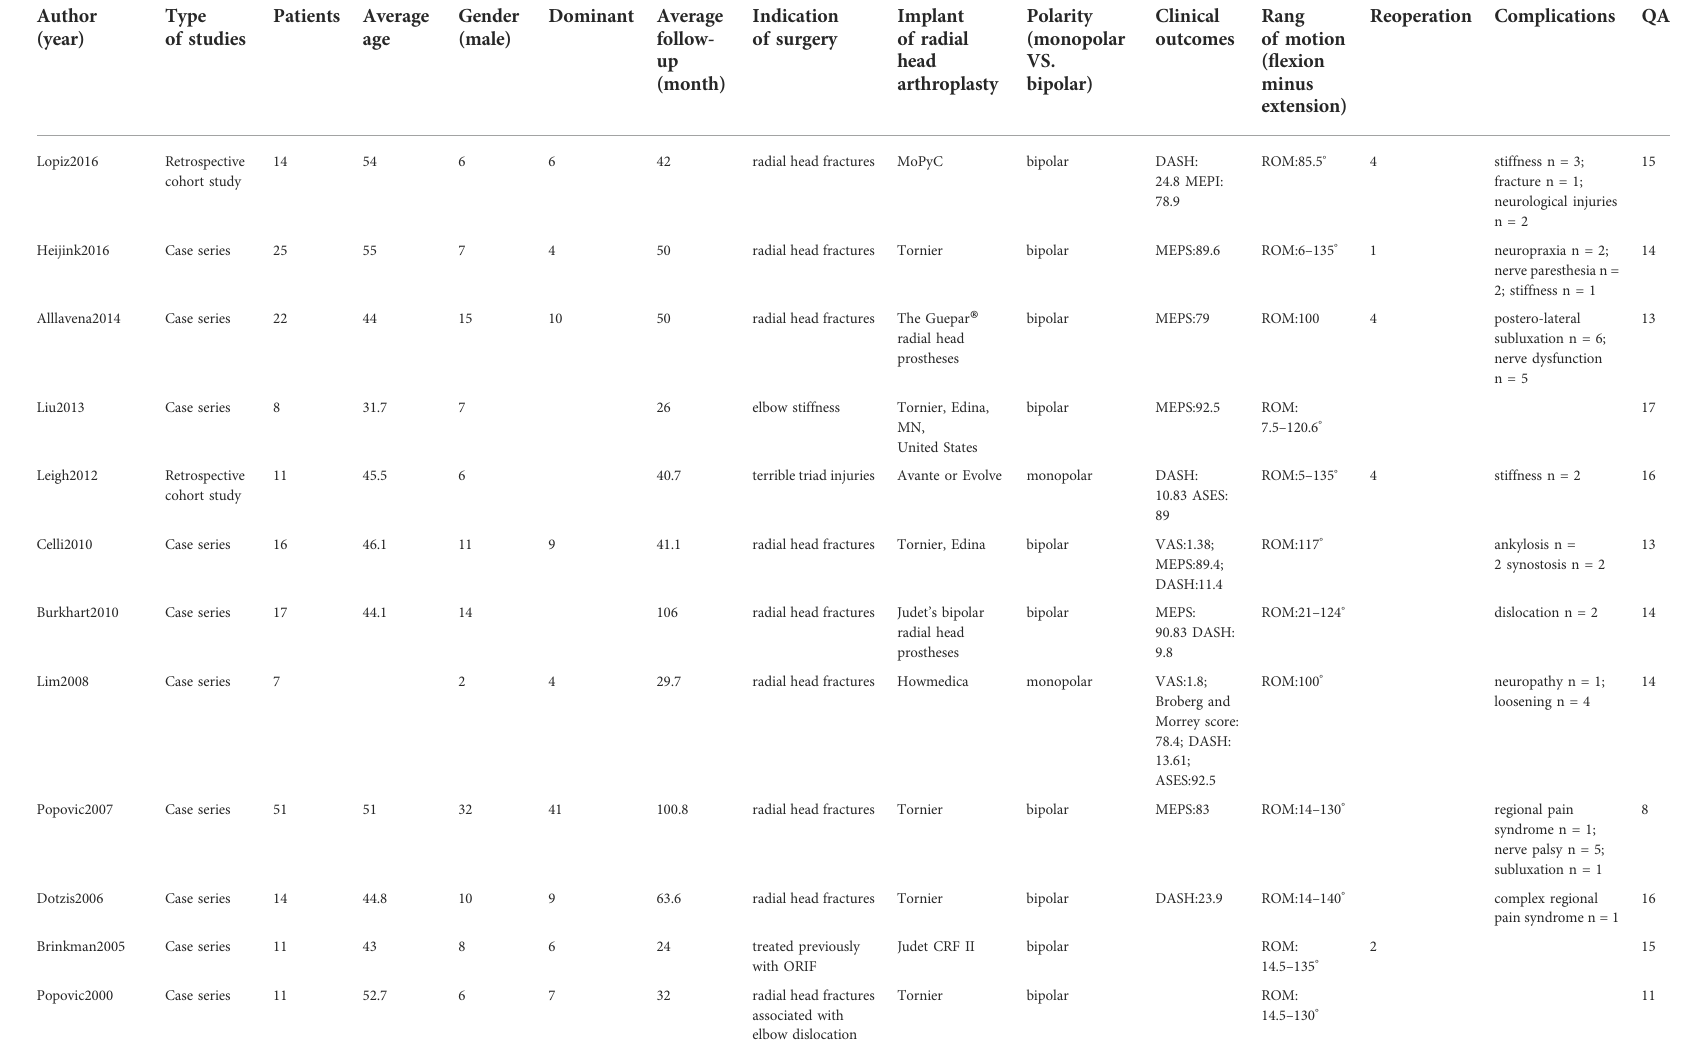
TABLE. 1 ( Continued ) Baseline demographics of the selected studies for cemented fi